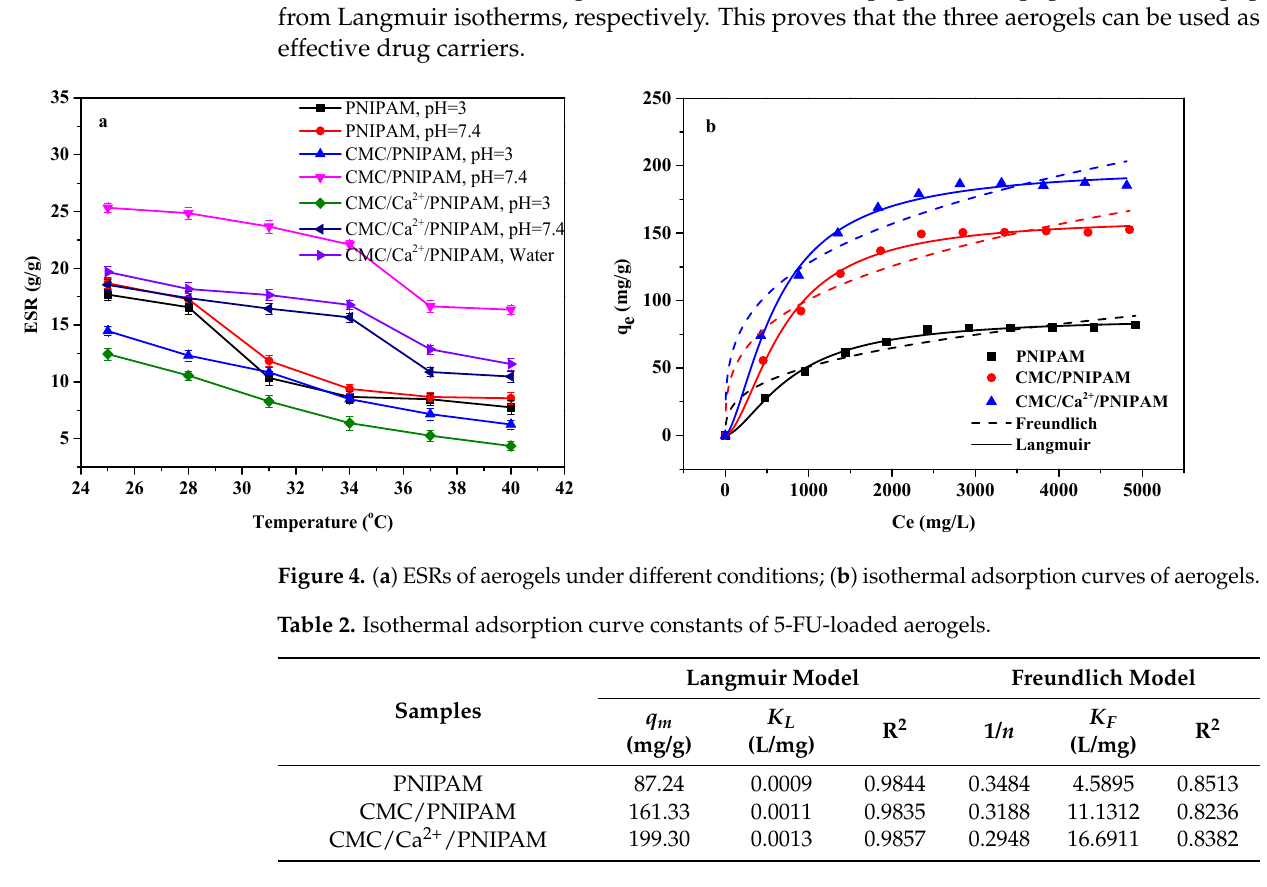
Table 2. Isothermal adsorption curve constants of 5-FU-loaded aerogels.